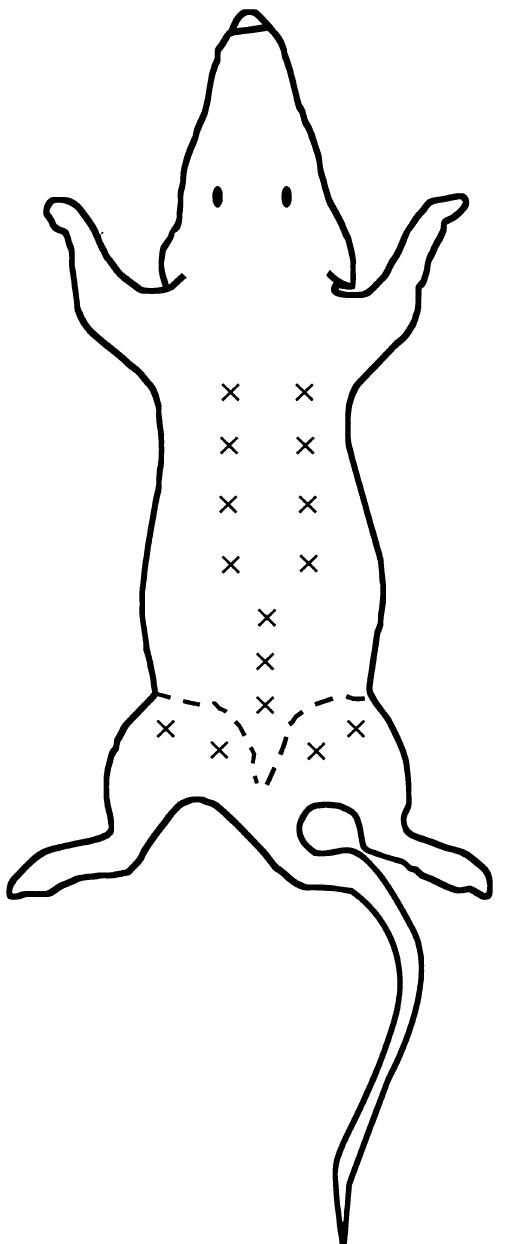
Figure 2. Analysis of density innervation per area and side (right and left): “ × ” indicate each area analyzed after immunohistochemical stains: from thoraco to sacral region of thoracolumbar fascia (both right and left side), and gluteal fascia (right and left